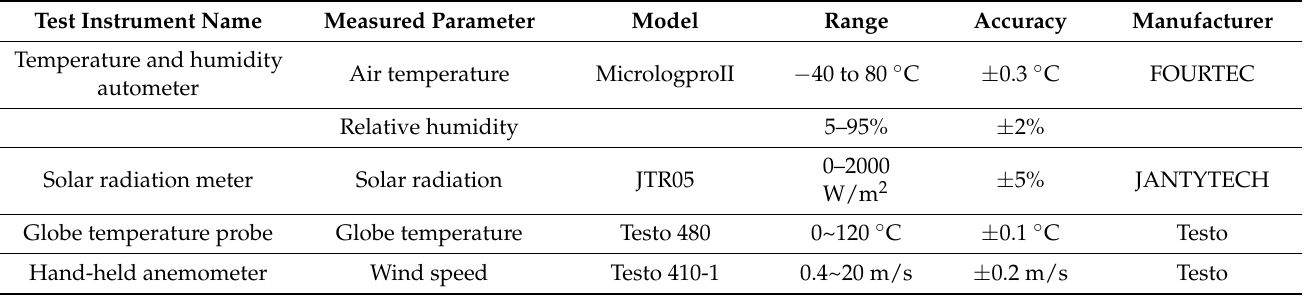
Table 3. The measurement instrument set and